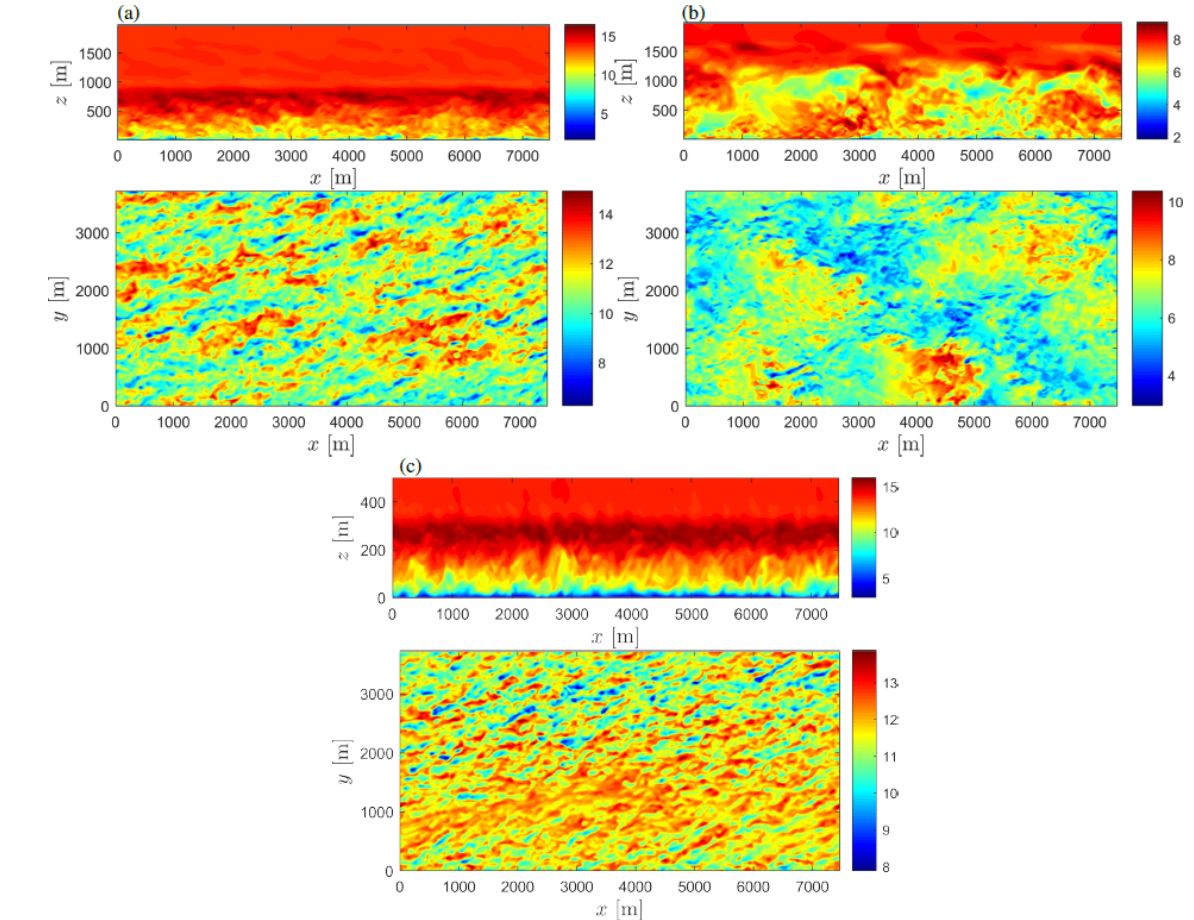
Figure 6. Instantaneous cross sections ( x – z through the middle of the domain and x – y at ≈ 100m height) of U at 13h for the neutral ABL simulation (a) , at 3h for the unstable ABL simulation (b) , and at 15h for the stable ABL simulation (c) . Note that the x – z cross section for the stable ABL simulation has an aspect ratio of 1 : 4, and z is limited to